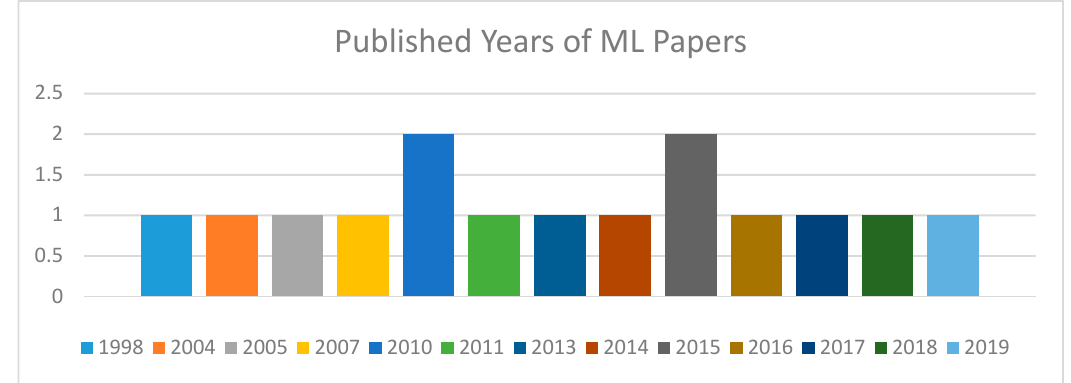
Figure 5. Published years of selected ML papers.